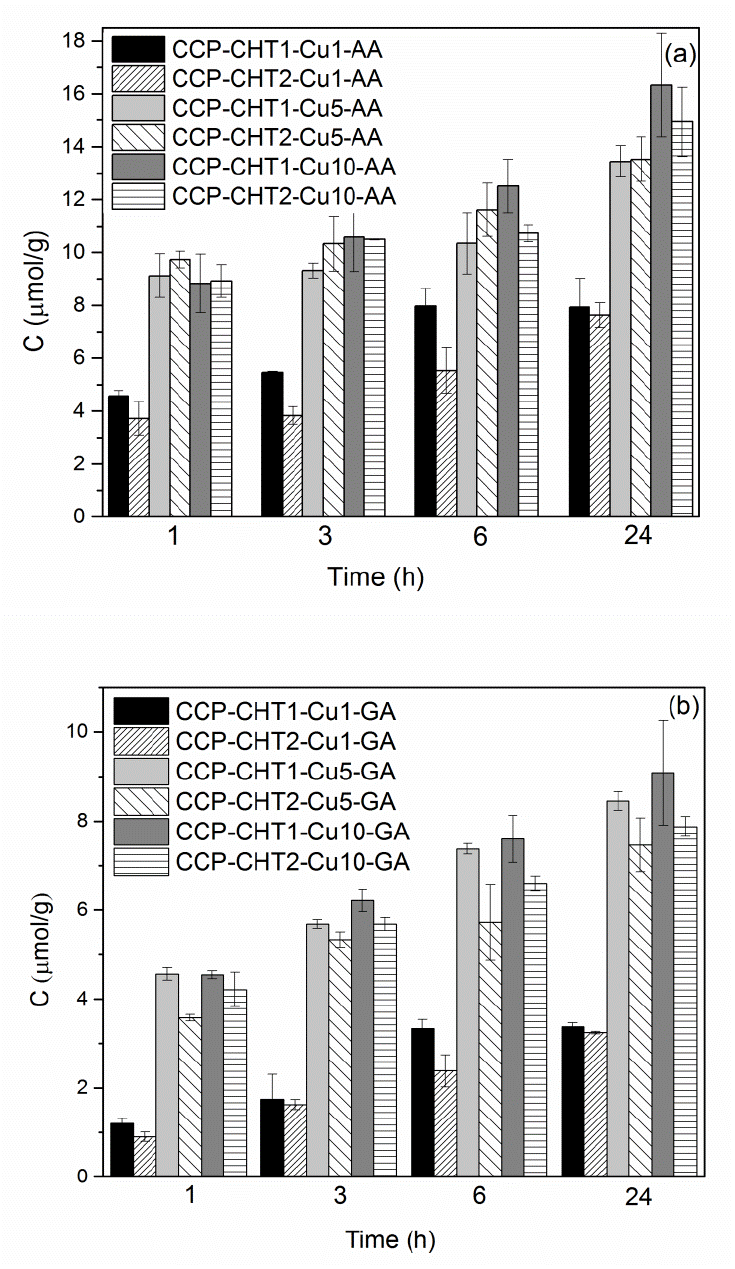
Figure 10. Release of Cu 2+ -ions into physiological saline solution from samples reduced with: ( a ) ascorbic acid; and ( b ) gallic acid.